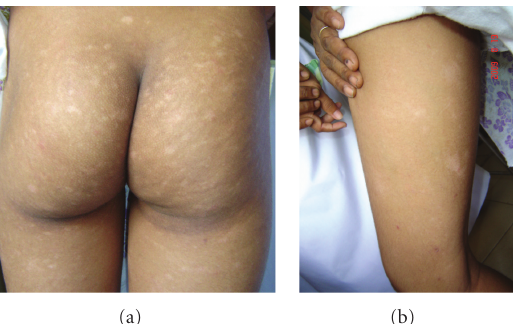
Figure 1: A 13-year-old girl presented with asymptomatic, hypo- pigmented, and a few vitiligo-like macules on buttocks and upper thigh involving bilaterally, which had been there for 3 years duration (patient